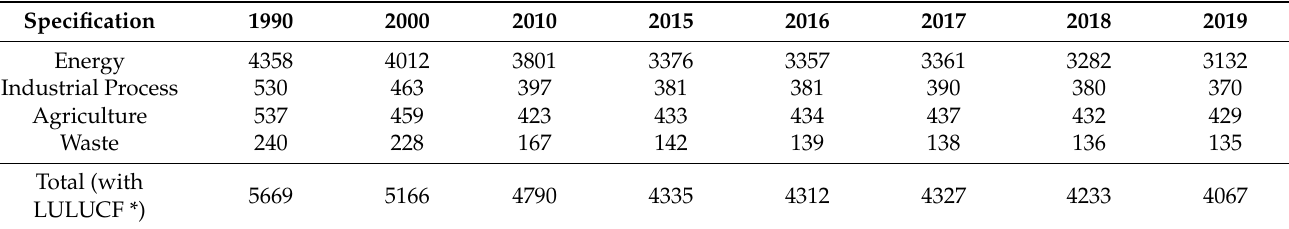
Table 5. Overview of EU greenhouse gas emissions (million tons of CO 2 equivalent) in terms of main sources and sinks in 1990–2019 [32]. Specification